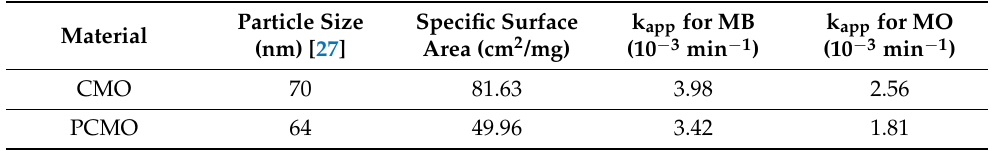
Table 1. Apparent first-order reaction constants obtained for MO and MB, and the band structure parameters determined by ab initio